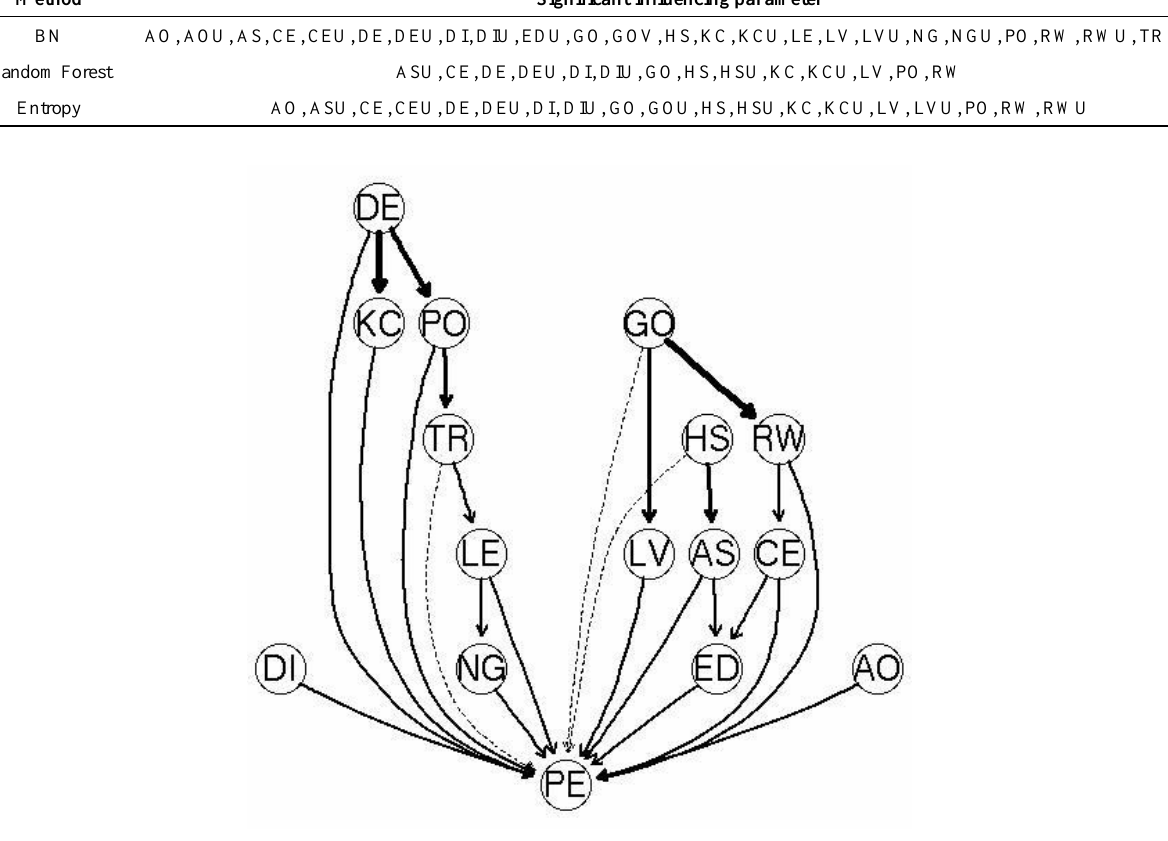
Figure 4. The Bayesian Network of significant (solid lines), insignificant (dashed lines) of influencing parameters on